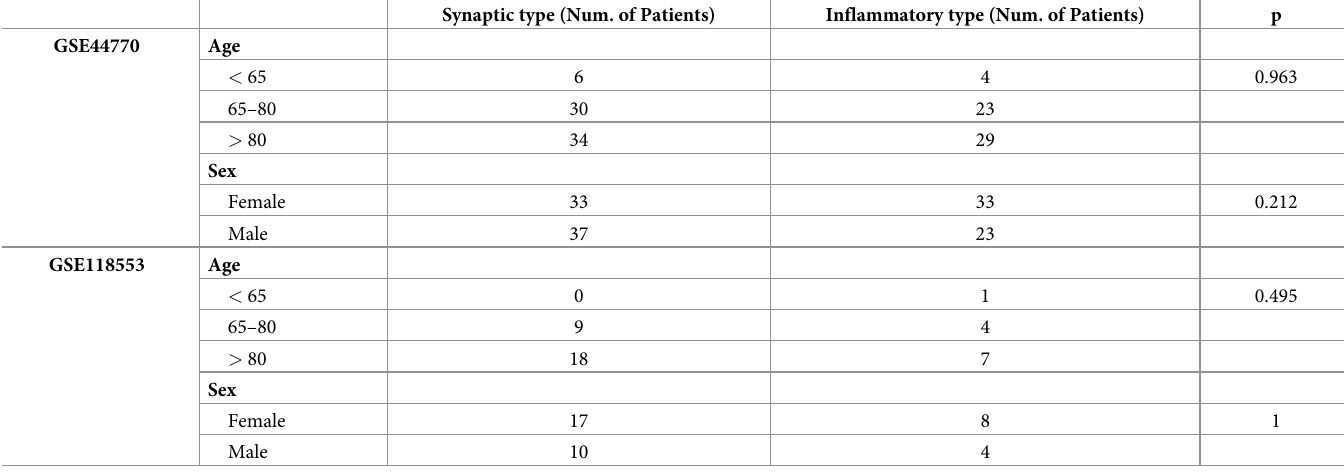
Table 4. Association of AD molecular subtype with age and sex in the two validation datasets. Synaptic type (Num. of